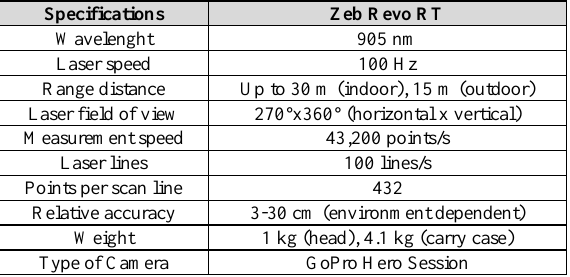
Table 5. Specification of the Zeb Revo RT.